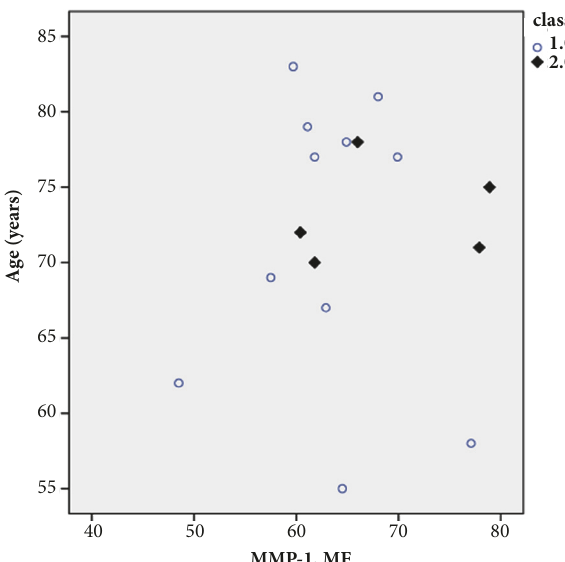
Figure 6: Scatterplot analysis of MMP-1 levels in male ( I ) and female ( Q ) versus age in symptomatic patients.